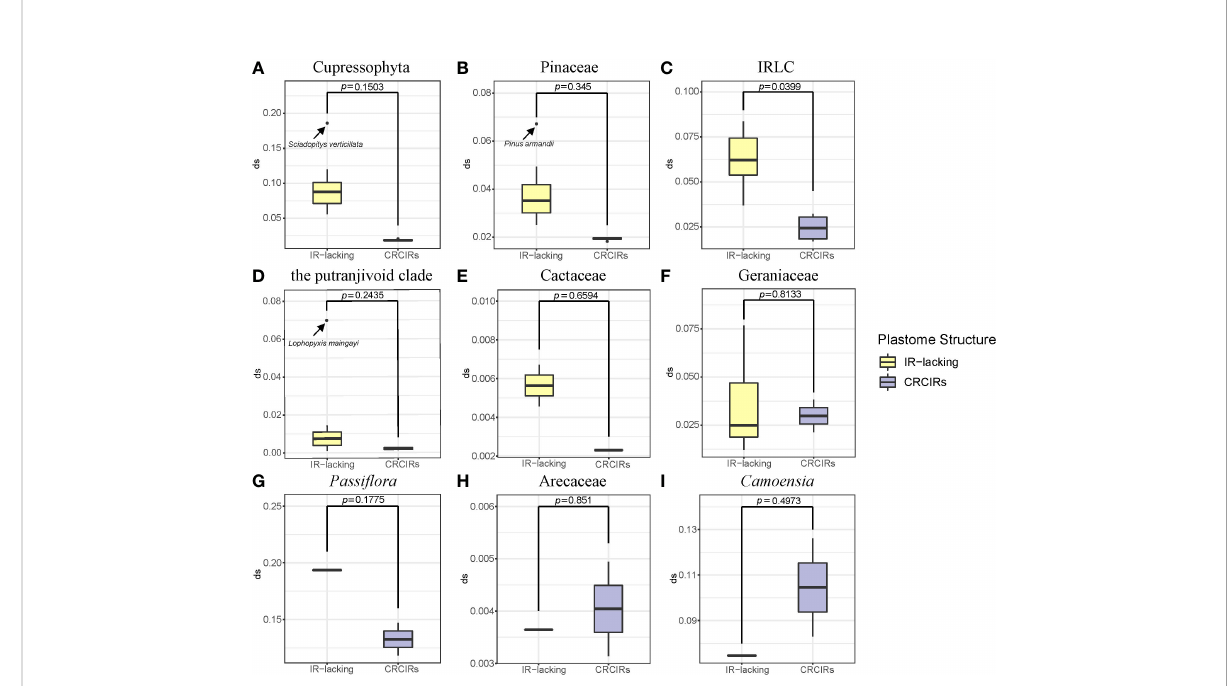
FIGURE 2 Boxplots for comparisons of synonymous substitution rates of whole protein-coding genes between IR-lacking plastomes and those of their CRCIRs with phylogenetic t-test. (A) Cupressophyta; (B) Pinaceae; (C) IRLC; (D) the putranjivoid clade; (E) Cactaceae; (F) Geraniaceae; (G) Passi fl ora ; (H) Arecaceae; (I) Camoensia . Thick lines within boxes are medians, and outliers are shown as circles.